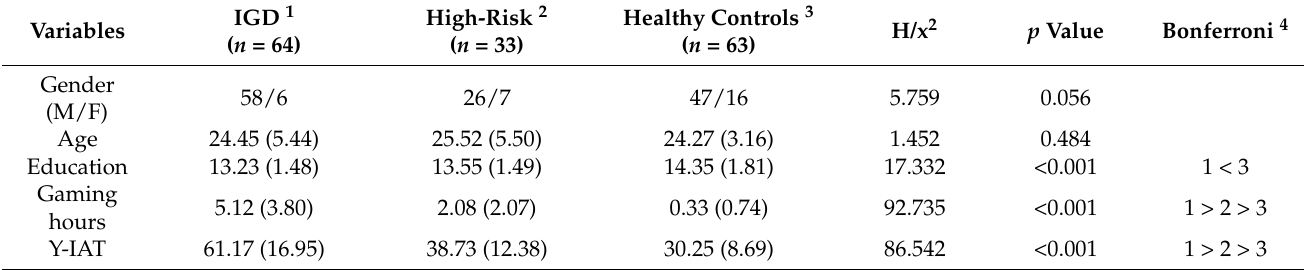
Table 1. Comparison of demographics among three groups ( n = 160).